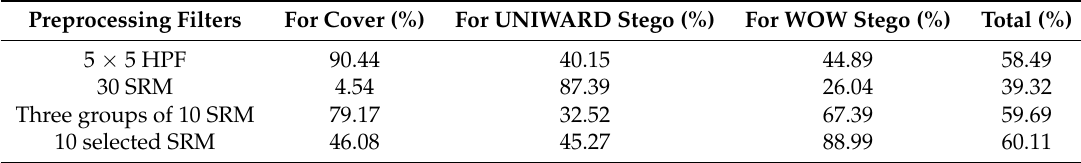
Table 8. Ternary classification rates of the base CNN with different preprocessing filters when increasing the feature maps in the first convolutional layers to 60 ( bpp =